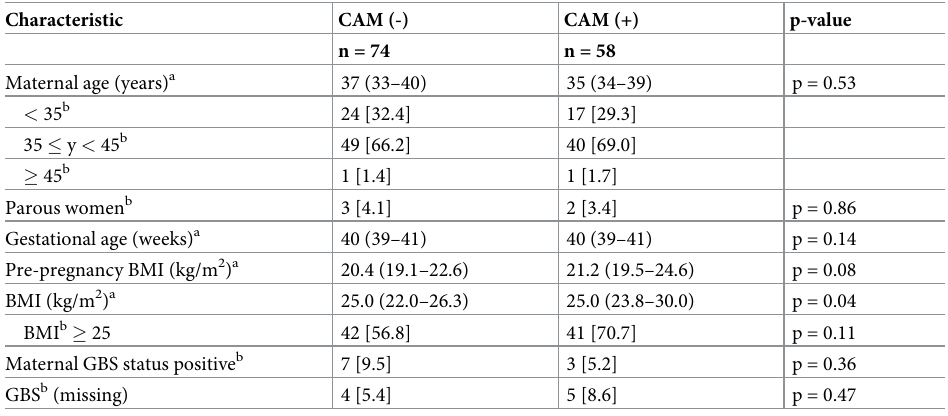
The failure rate of epidural conversion is shown in Table 3. The failure rate in the CAM (+) group was 46.6%, which was significantly higher than the 18.9% in the CAM (-) group (crude OR 3.7, 95% CI 1.7–8.3, p < 0.001). In the CSEA subgroup analysis, the failure rate in the CAM Table 1. Baseline characteristics of the study